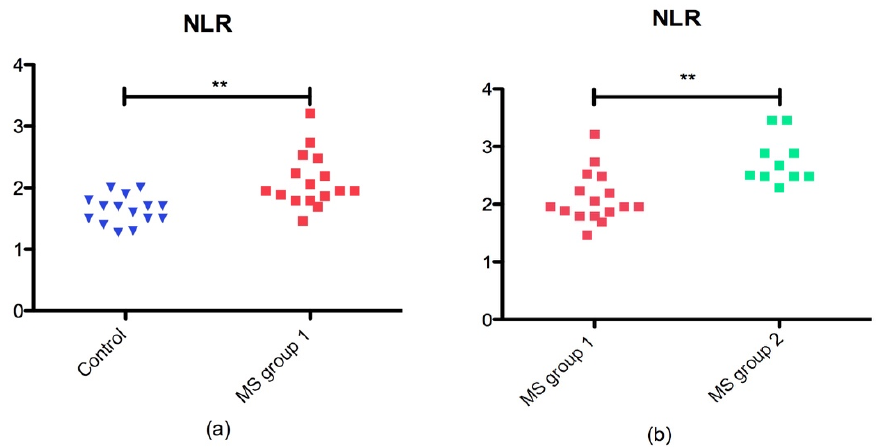
Figure 1. NLR in MS groups and control group: ( a ) scatter plot of NLR in control group and MS group 1 ( p = 0.0025**); ( b ) scatter plot of NLR in MS group 1 and MS group 2 ( p = 0.0010**).